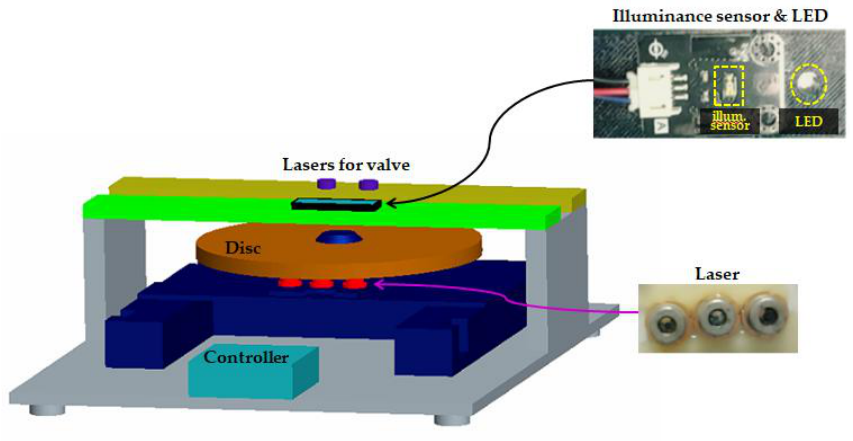
Figure 1. System for Lab-on-a-Disc and testing.